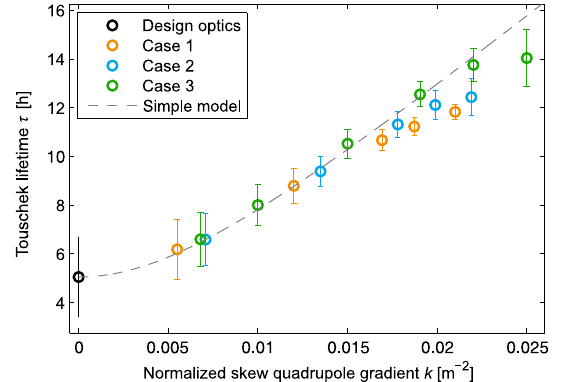
FIG. 11. Touschek lifetime as a function of skew quadrupole gradient. Tracking with errors, average and standard deviation for 10 seeds. Only the gradient of the strongest skew quadrupole used in each case is considered in this plot.